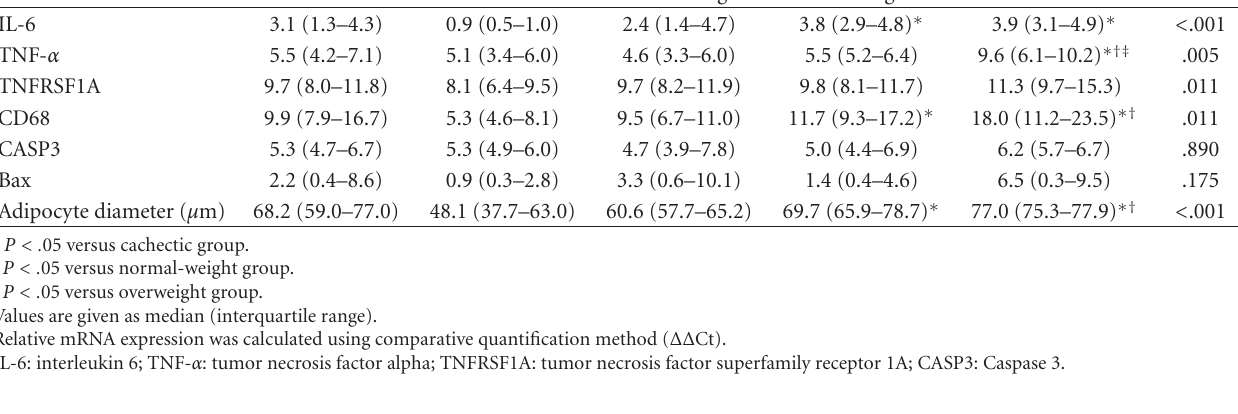
Table 5: Linear relationships between IL-6, TNF- α , and CD68 relative expressions in adipose tissue and insulin sensitivity, BMI, adipocyte diameter, FEV 1 , arterial oxygen saturation, and serum inflammatory